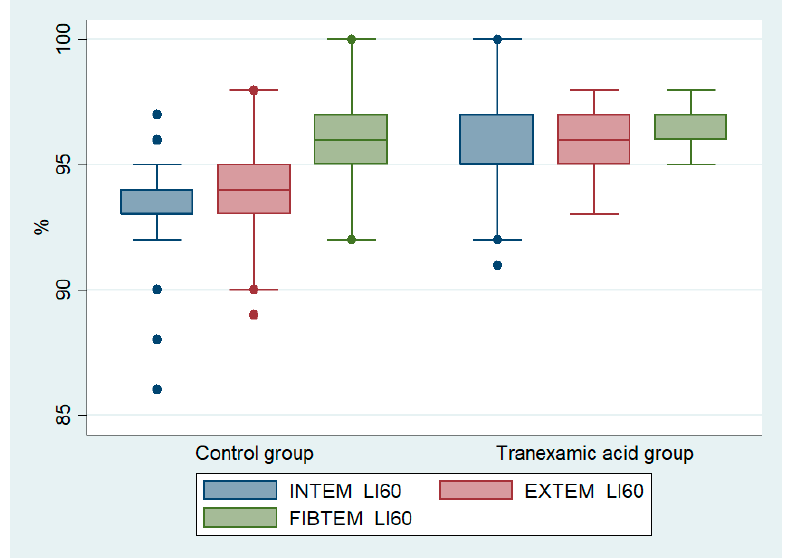
Figure 1. Boxplots of INTEM, EXTEM and FIBTEM LI60 results of patients with and without the use of tranexamic acid.